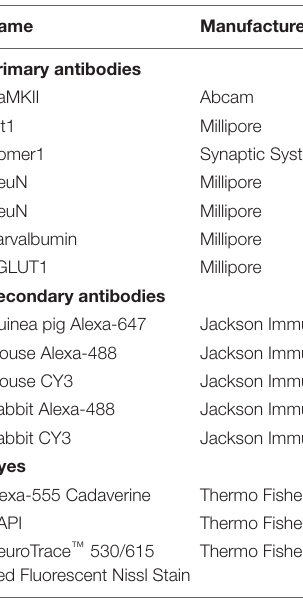
TABLE 1 | List of antibodies and